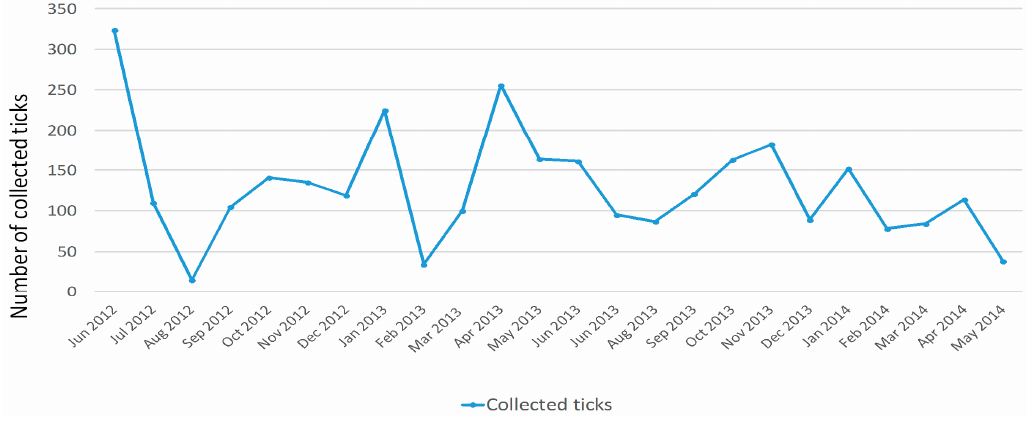
Figure 6. Monthly trend of collected ticks during the months of monitoring.